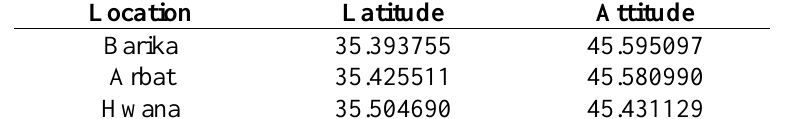
Fig. 1. Location of soil bore holes, A-Sulaimani governorate location in Iraq, B-The cities of Sulaimani Governorate, consists of the place of collected soil samples (Iraq Maps, 2021 from www.google.iq). Table 1. Latitude and Attitude data for the selected places of soil samples in Sulaimani